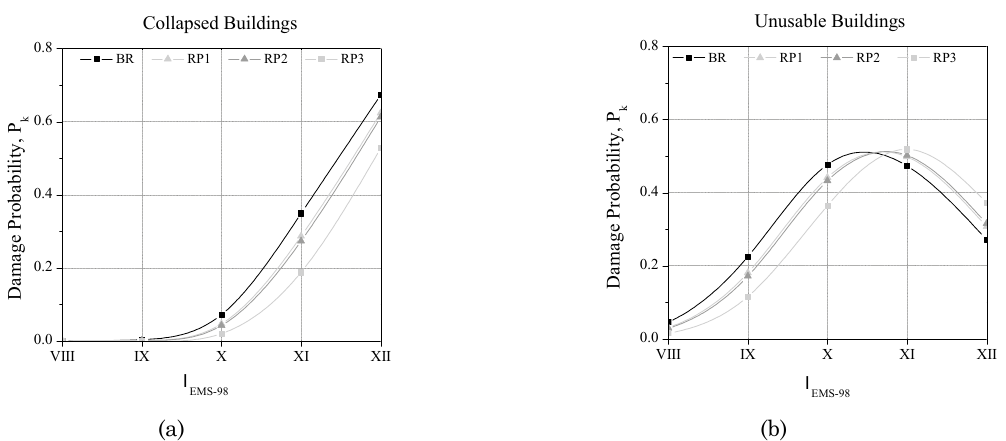
fig. 4. Probability of collapsed (a) and unusable buildings (b) for the different building conditions analysed Table 5. Estimation of the number of collapsed and unusable buildings, for a total of 192 buildings evaluated intensity Collapsed buildings I EMS-98